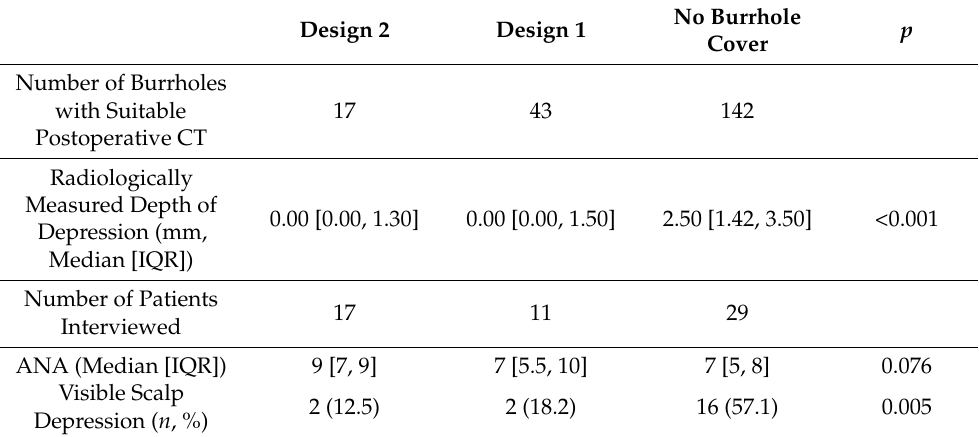
Table 3. Cosmetic outcome